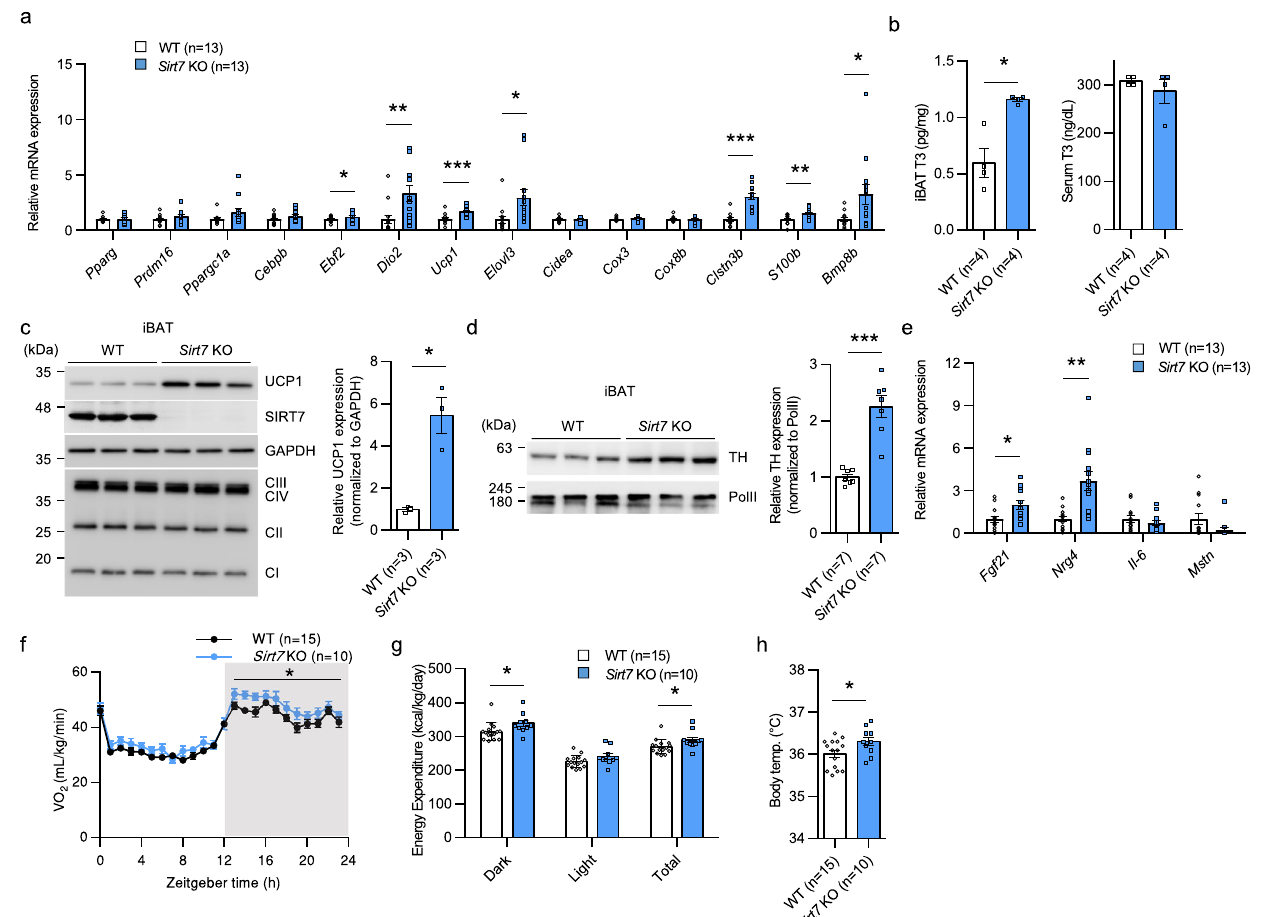
Fig. 3 | SIRT7 suppresses energy expenditure and thermogenesis via multiple pathways. a Real-time qPCR analysis of BAT-related genes in iBAT of 15-week-old maleWTand Sirt7 KOmice. p =0.0288( Ebf2 ), p =0.0098( Dio2 ), p =0.0003( Ucp1 ), p =0.0206( Elovl3 ), p =3.4E – 06( Clstn3b ), p =0.0053 ( S100b ), p =0.0296( Bmp8b ). b T3leveliniBATandserumof13-week-oldmaleWTand Sirt7 KOmice. p =0.0192. c WesternblotanalysisofUCP1andOXPHOScomplexesI – IViniBATof15-week-old male WT and Sirt7 KO mice (left panel), and quanti fi cation of the UCP1 protein bands relative to GAPDH control (right panel). p =0.0347. d Western blot analysis oftyrosinehydroxylase(TH)iniBATof15-week-oldmaleWTand Sirt7 KOmice(left panel), and quanti fi cation of the TH protein bands relative to RNA Polymerase II